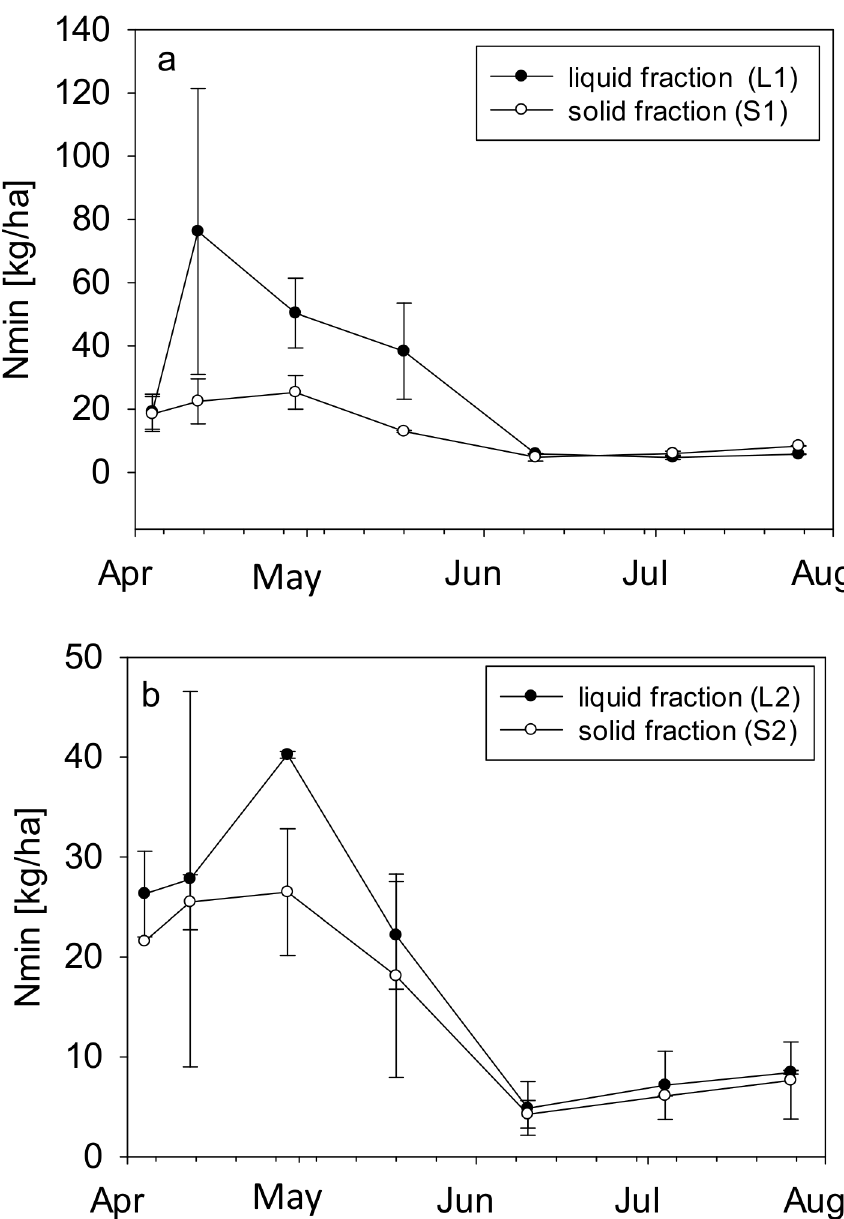
Fig 3. Temporal sequence of mineral nitrogen (Nmin) in soil (0-20cm depth) during the vegetation period in plots fertilized with a) L1 = liquid fraction of BGR from biogas plant 1 and S1 = solid fraction of BGR from biogas plant 1 and b) with L2 = liquid fraction of BGR from biogas plant 2 and S2 = solid fraction of BGR from biogas plant